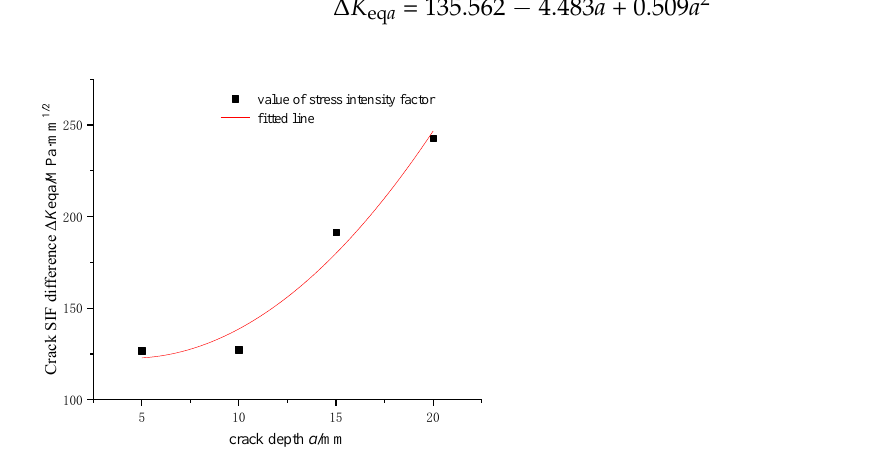
Figure 12. Fitting curve of crack stress intensity factor with crack depth. According to reference [4,10], the calculation flow of cutterhead crack-growth life is presented as Formula (7) based on the Paris model.